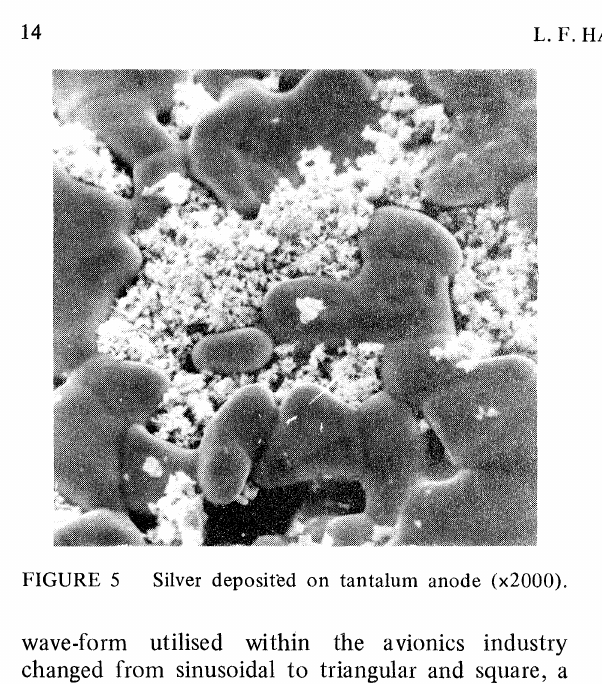
FIGURE 5 Silver deposited on tantalum anode (x2000).